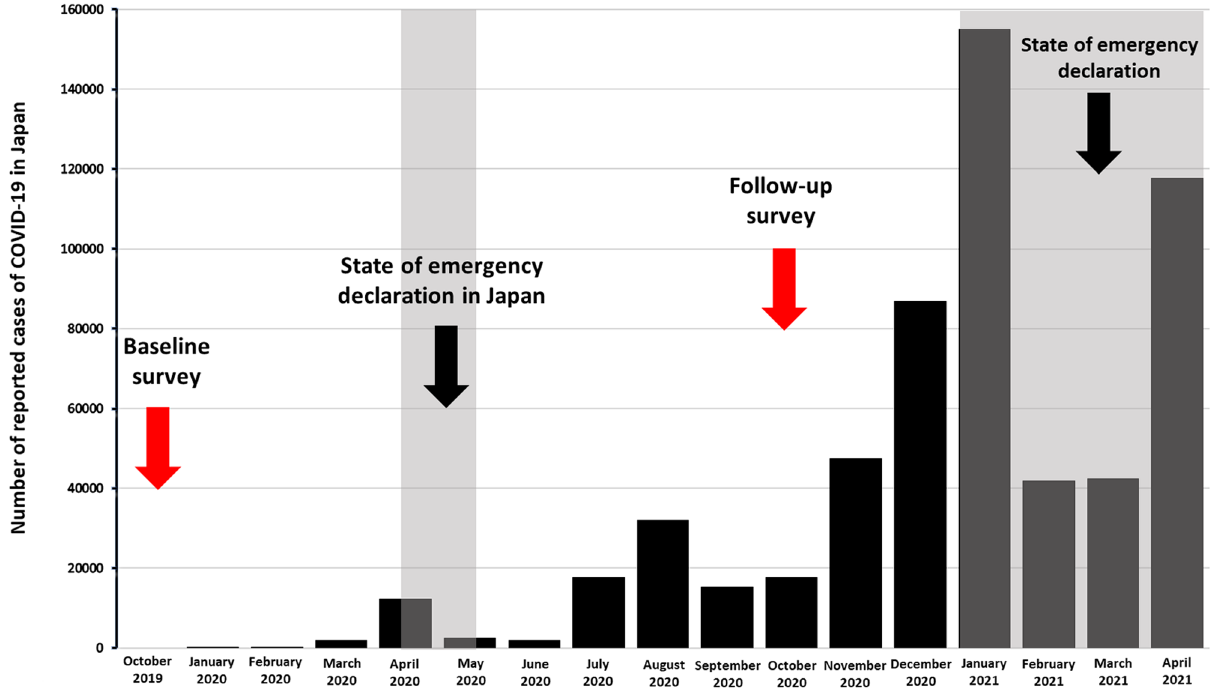
Figure 1. Research period and number of reported cases of COVID-19 in